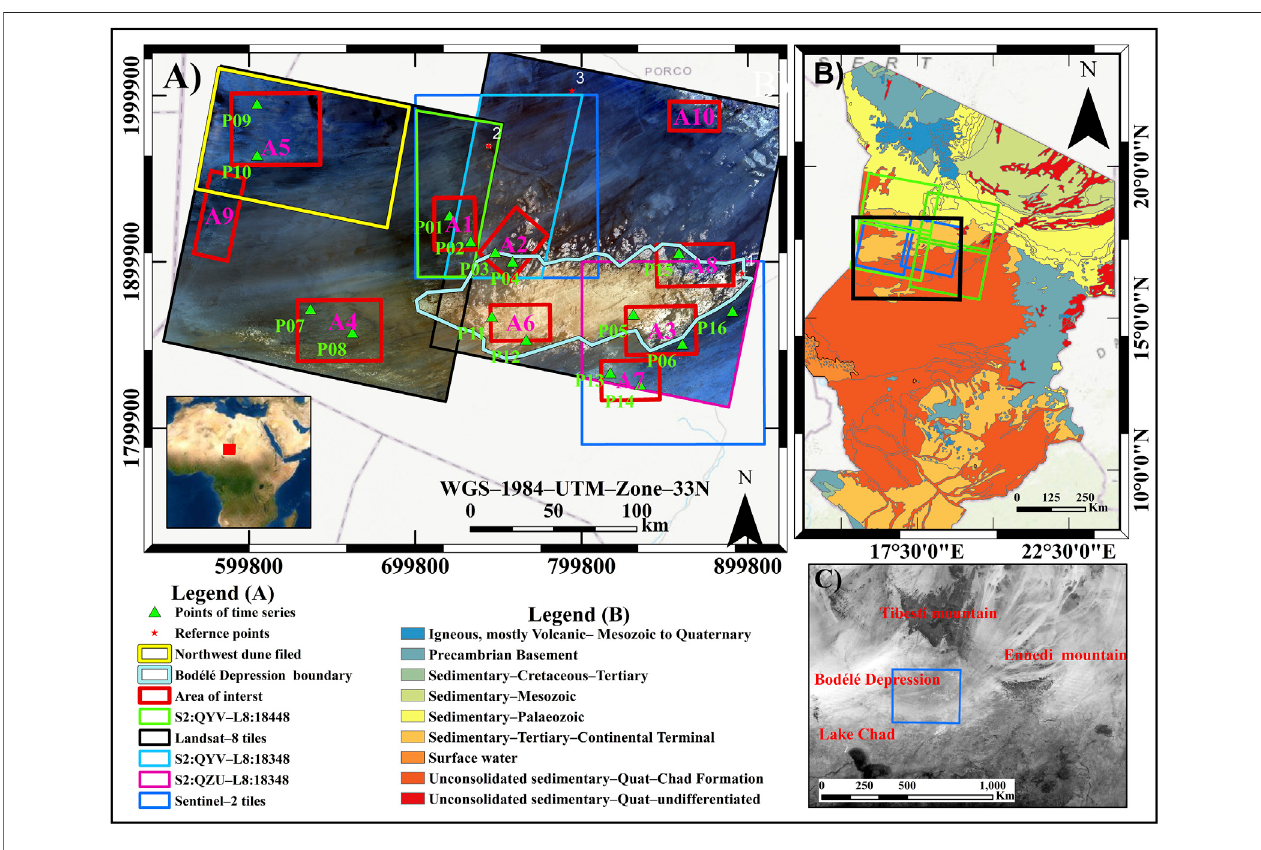
FIGURE1| Geographicalpositionandgeologicalformationofthestudyarea.Panel (A) indicatesthelocationoftheBodéléDepression.Theinsetshowsthelocationof theBDinAfrica.Thebackgroundinpanel (A) isamosaicofLandsat-8falsecolors.TheblackrectanglesdenotethecoverageofLandsat-8(i.e.,P:183/R:48andP:184/R:48). The blue rectangles denote the coverage of Sentinel-2A/B (i.e., TR33QYV and TR33QZU). The red rectangles represent the dune fi elds for which we discuss the spatiotemporalvariabilityin Section4.6 .Theredpentagramsrepresentthereferencepointsusedforabsolutecalibration,whilethegreentrianglesrepresentthepoints forwhichweextractedthetemporalevolutionofdunemigrationin Section4.5 .Thethreecoloredpolygonsinpanel (A) representtheoverlapareasbetweenLandsat-8and Sentinel-2, where we performed the inversion of the fused offset maps. Panel (B) shows the geological and geomorphological formations of Chad. The black rectangle representstheareashowninpanel (A) .ThegreenrectanglesdenotetheSentinel-1Acoverage(i.e.,descendingtracks07and 80).Panel (C) showsthelocationoftheBDin the gap between the Tibesti and Ennedi mountains, and the current coverage of Lake Chad to the southwest. The background is the MODIS surface re fl ectance.